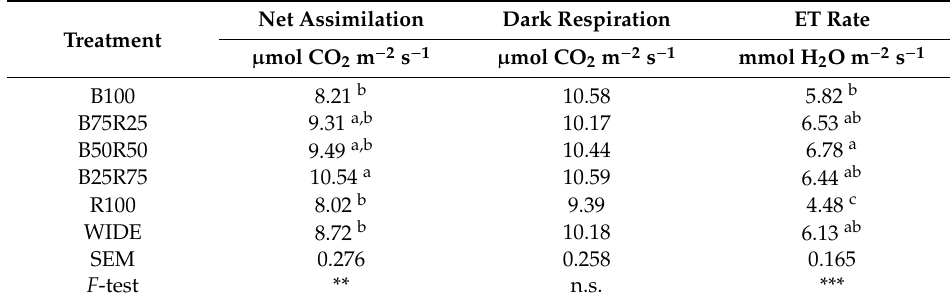
Table 1. Net assimilation, dark respiration, and evapotranspiration of einkorn seedlings at Zadoks’ 12. SEM: pooled standard error of the mean. ** and *** indicate that the values are significantly di ff erent for p < 0.01 and p < 0.001, respectively; n.s. indicates that the values are not significantly di ff erent. Means followed by the same letter are not di ff erent for p < 0.05 (Tukey’s HSD